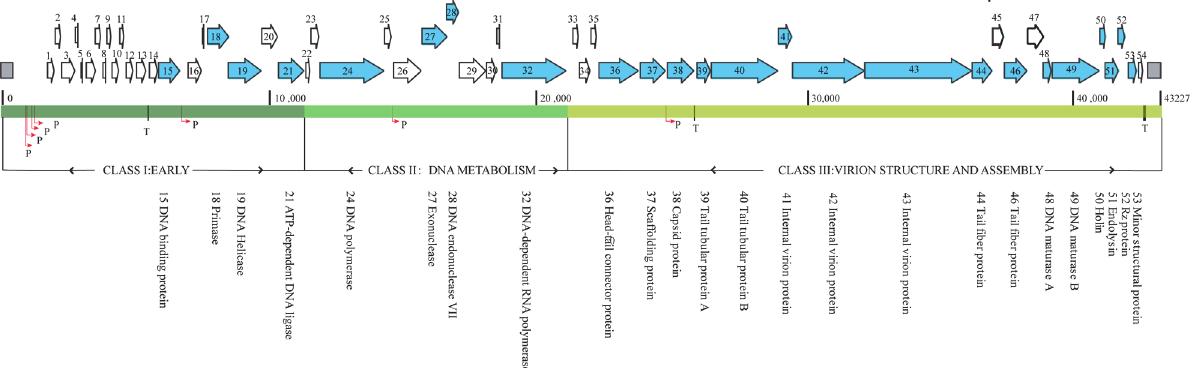
Figure 4. Overview of the PPA-ABTNL genome sequence analysis. Predicted open reading frames (ORFs) are numbered. ORFs with significant homology to known genes and to the identified proteins are in dark blue. Putative genome organization. Putaitve promoters ( ↳ ), terminators ( Ⅰ ) are indicated. Predicted and presumed proteins and corresponding ORF number are